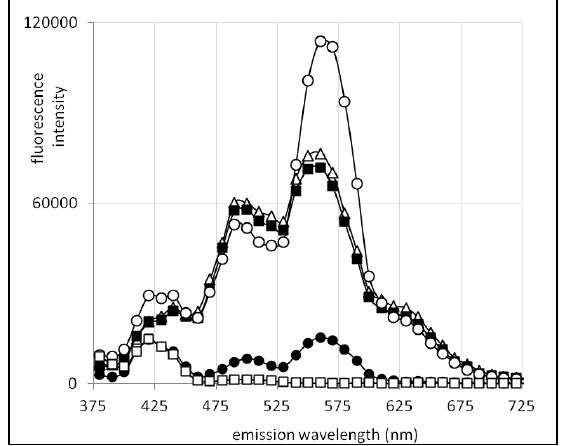
Figure 2. Figure 2: Influence of detergents on heme breakdown. Triton X-100 ( n ), Igepal 630-AN ( D ) or o Tween® 20 ( ) was added to erythrocyte lysis buffer containing 0.5% ascorbate. The lysates were scanned • for fluorescence after 4 h of incubation. Profiles of ), 2 h detergent-free erythrocyte lysate are shown after 4 h • ( ) and 6 min ( ¤